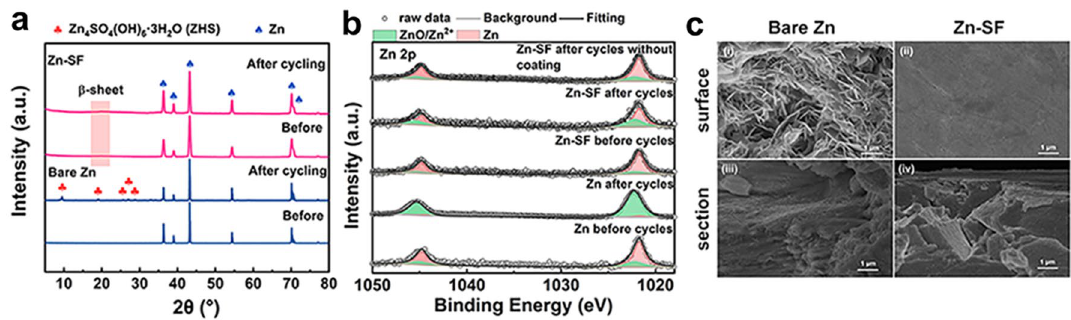
Fig. 5 Structure characterization of bare Zn and Zn‑SF electrodes before/after long‑term cycles. a XRD patterns of bare Zn and Zn‑SF anodes before/after cycles (Zn, PDF#04–0831; ZHS, PDF#39–0689). b XPS data of Zn 2 p spectrum of two anodes before/after cycles. c, d SEM images of bare Zn ( c, i/iii ) and Zn‑SF ( d, ii/iv ) anodes after